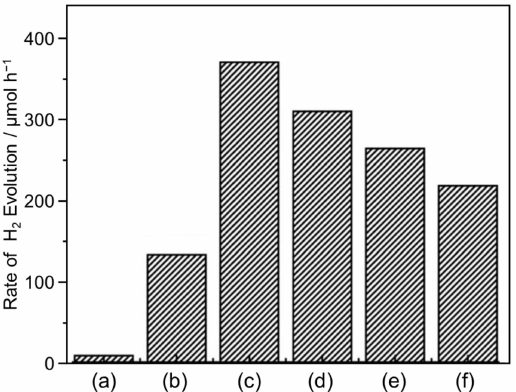
Figure 20. Photocatalytic H 2 evolution from 50 vol% aqueous methanol solution under high-pressure Hg lamp irradiation over (a) bare SrTiO 3 and (b–f) Cu 1 − x Pt x /SrTiO 3 ( x = (b) 0, (c) 0.05, (d) 0.1, (e) 0.9, or (f) 1.0) NPs. Reproduced with permission from reference [219]. Copyright 2015 The Royal Society of